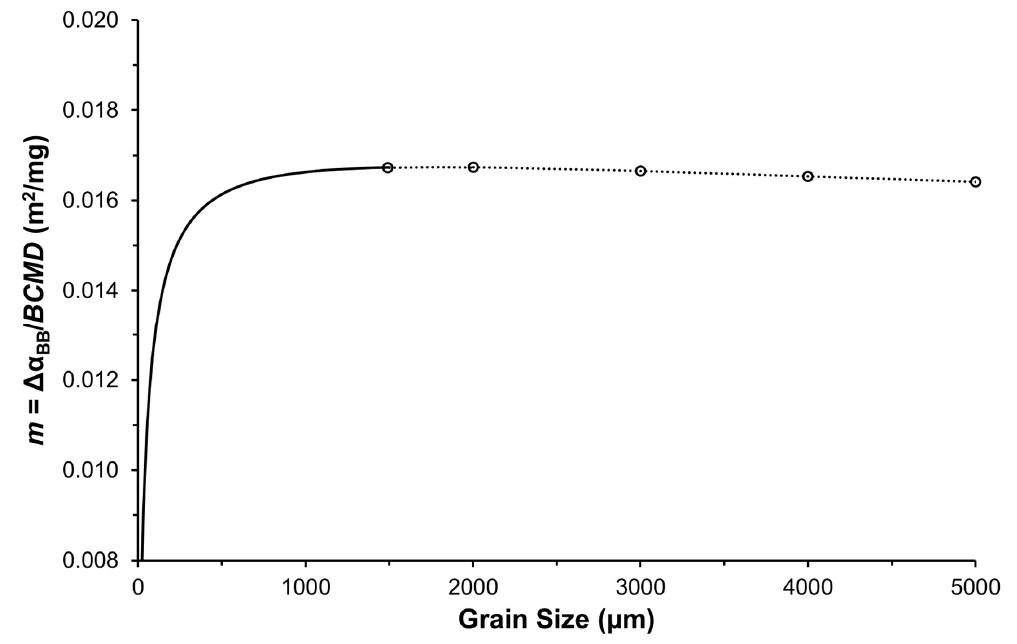
Figure 6. Slope m as a function of grain radius for 0 mg / m 2 ≤ BCMD ≤ 3 mg / m 2 . The grain radius resolution is 1 µ m for the range 10–1500 µ m and the values of m are shown as a continuous line, whereas the more discrete calculations of m for grain radii of 1500, 2000, 3000, 4000, and 5000 µ m are shown as open circles interpolated with a dotted line.